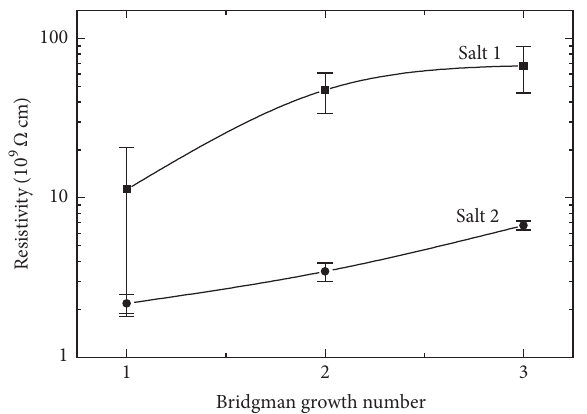
Figure 7: Resistivity of the TlBr detector from crystal middle region (slice ∼ 0.65 mm thick) as a function of the repetition number of Bridgman growth. The bar error represents one standard deviation ( 𝑁 = 3 samples).